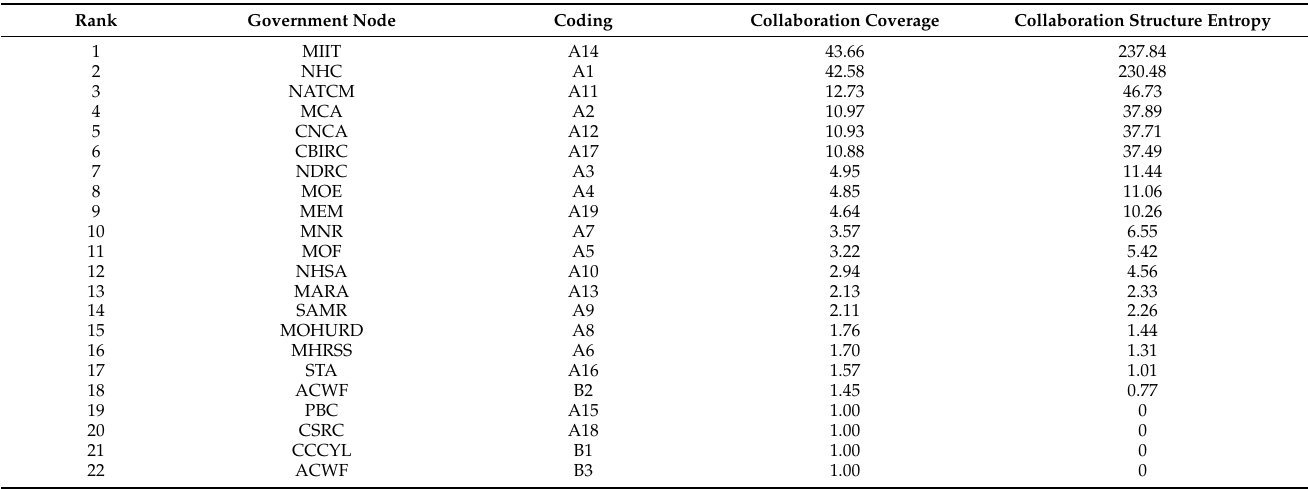
Table 6. The results of the collaboration coverage and the collaboration structure entropy.